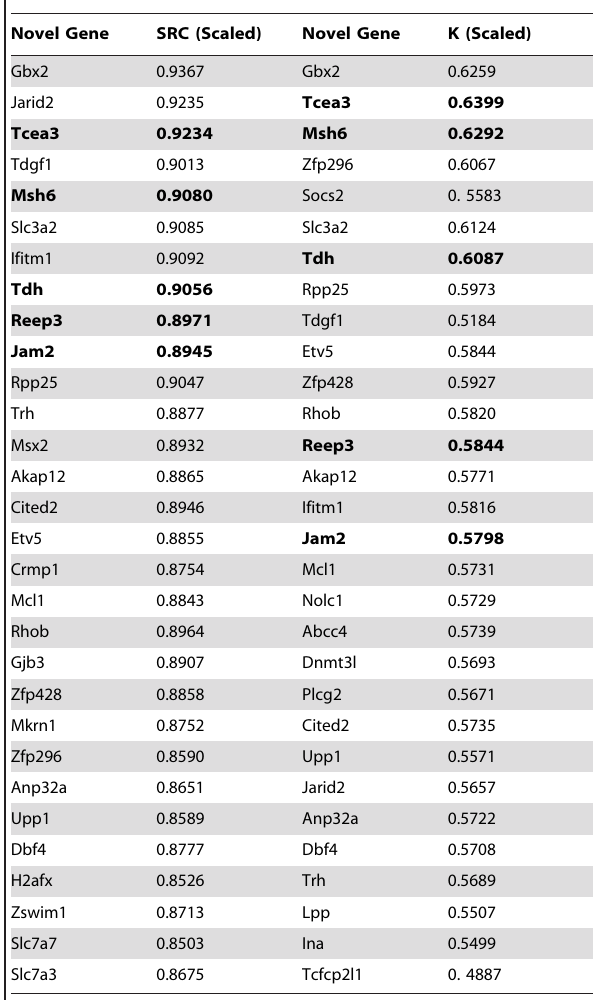
Table 2. Candidate Genes for Experimental